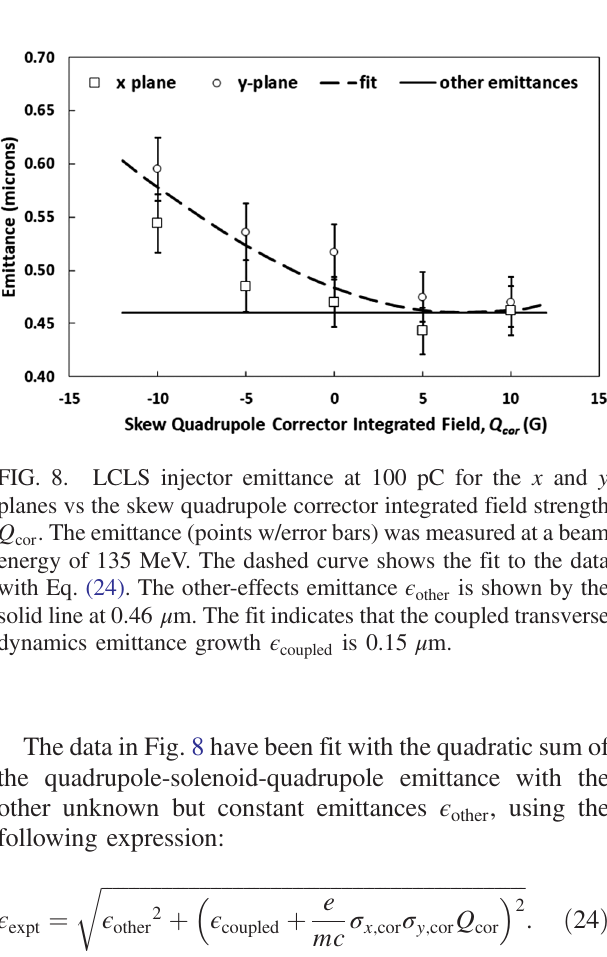
FIG. 7. Simulations of emittance cancellation with a quadru- pole corrector: The emittance without a quadrupole field at the solenoid entrance (blue line), the emittance with a normal quadrupole at the entrance of the solenoid (green line), and emittance correction with a quadrupole corrector downstream of the solenoid (red line).